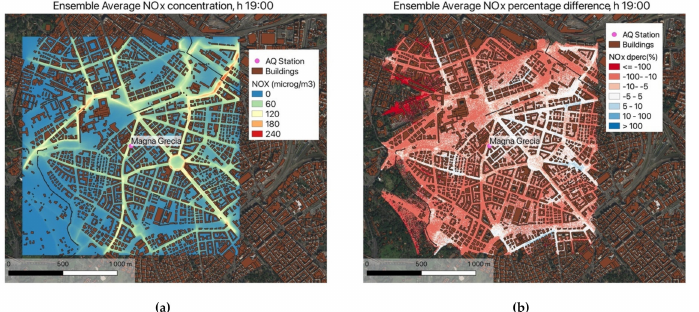
Figure 14. Maps of the ensemble average of the NOx concentration (Sim 3) at 19:00 ( a ) and the ensemble average of the NOx percentage difference at 19:00 ( b